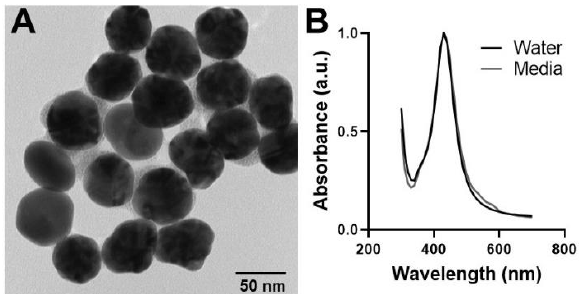
Figure 1. Characterization of the experimental 50 nm AgNP stock. ( A ) A representative TEM image of the 50 nm PVP-coated AgNPs is shown. This image verifies spherical morphology and an even particle size distribution. ( B ) The spectral profiles for the 50 nm AgNPs in both water and media demonstrate a sharp, single peak, further verifying particle uniformity.